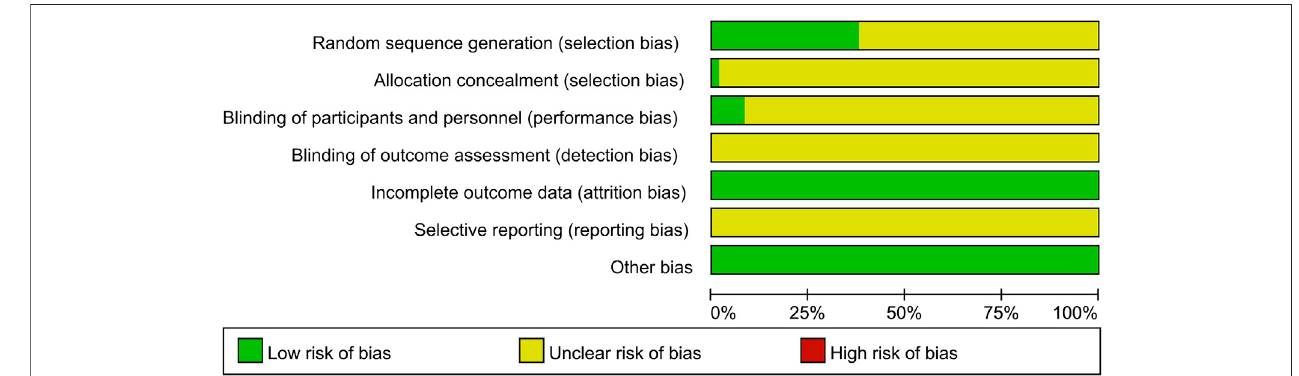
FIGURE 2 | Risk of bias graph.